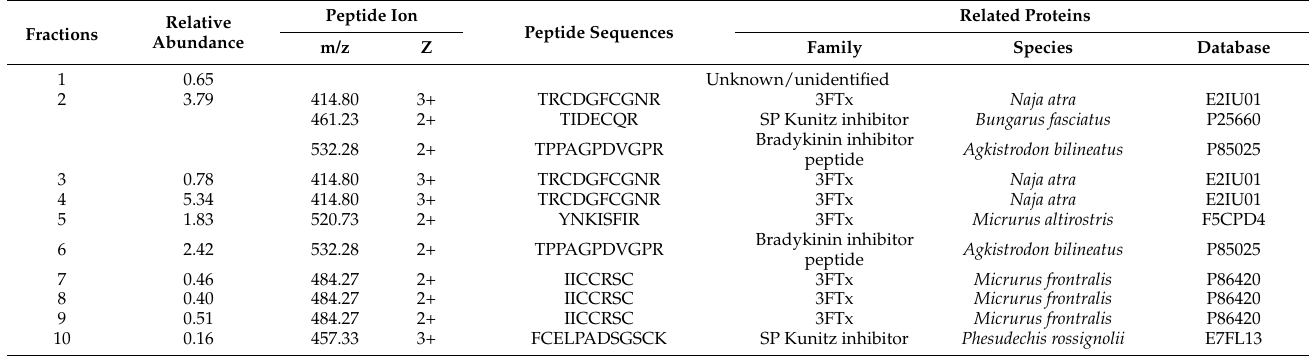
Table 1. Overview of MS/MS identification of M. helleri toxins found in SDS-PAGE gel and/or RP- HPLC fractions. Protein assignment was achieved by matching MS/MS-derived peptide sequences with snake venom toxin databases.